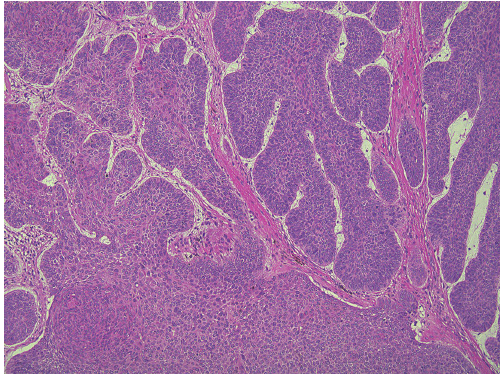
Figure 2: Microphotograph of nodular basal cell carcinoma (hematoxylin and eosin (HE) staining). Note tumor cells with large and hyperchromatic ovoid nuclei and little cytoplasm showing peripheral palisading.